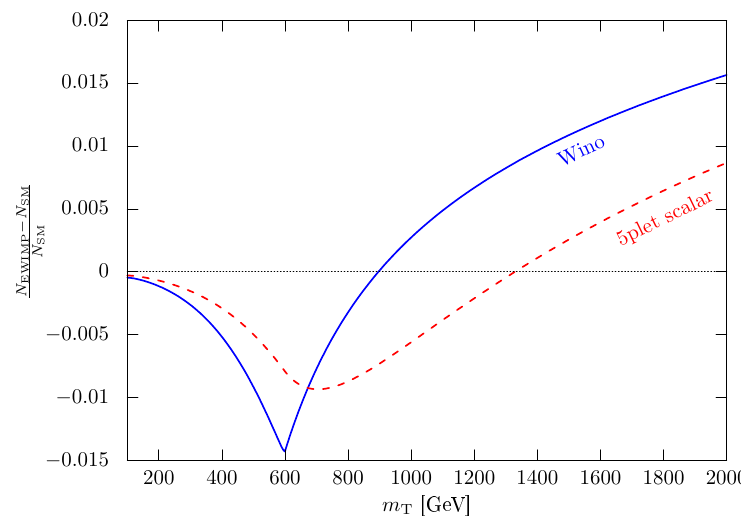
Figure 3 . The EWIMP correction to the transverse mass distribution at the 13 TeV running LHC. The blue and solid line shows the corrections from the 300 GeV Wino and red and dashed 300 GeV 5plet real